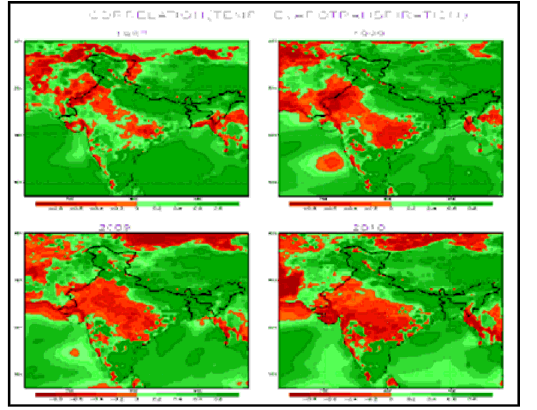
Figure 3. Correlation between temperature (K) and evapotranspiration (mm/day) ρ (E, T) using BATS scheme for El Niño (1987,2009), La Niña (1999,2010) years.